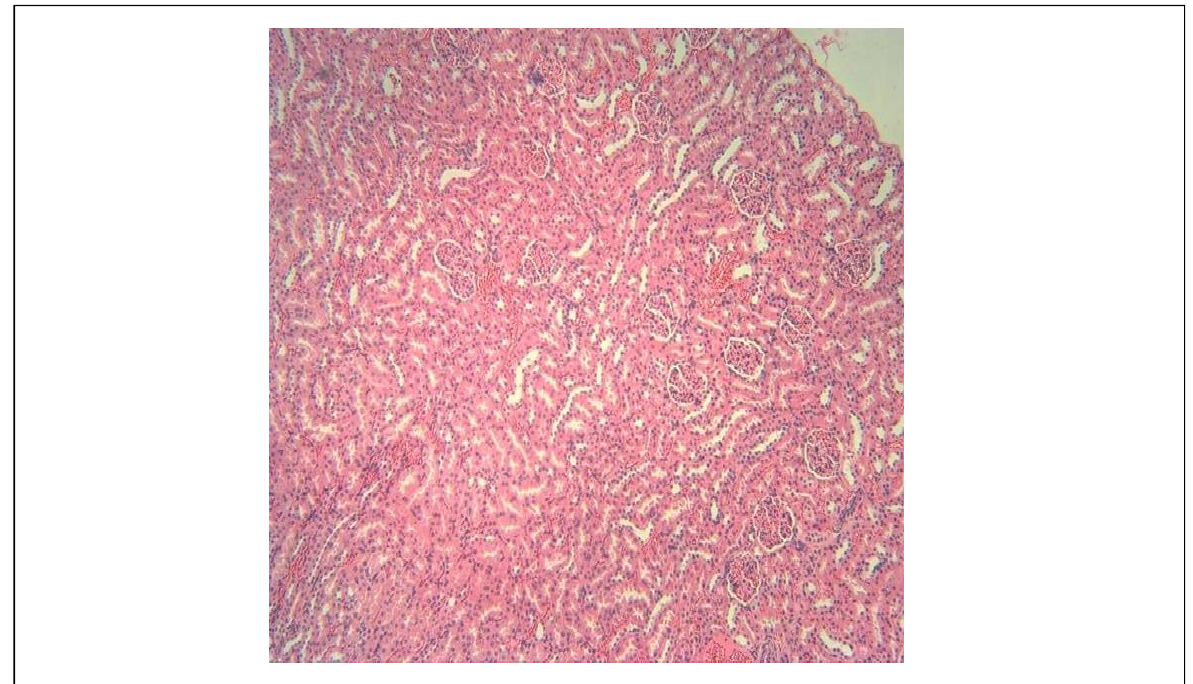
Photomicrographs of the kidney section of group B rats administered with N. laevis 400 mg/kg + MSG 8,000 mg/kg showed evenly distributed glomeruli of normal size, density of up to 13 per HPF with normal mesangial cellularity and stroma, normal endothelial epithelium with renal architecture, open glomerular capillaries, presence of distal and proximal tubules (Mg. X400).